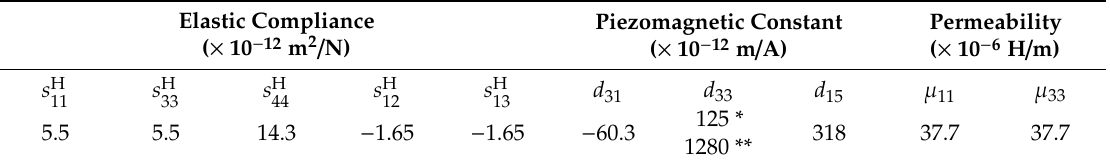
Table 1. Material properties of the Fe-Co bulk.